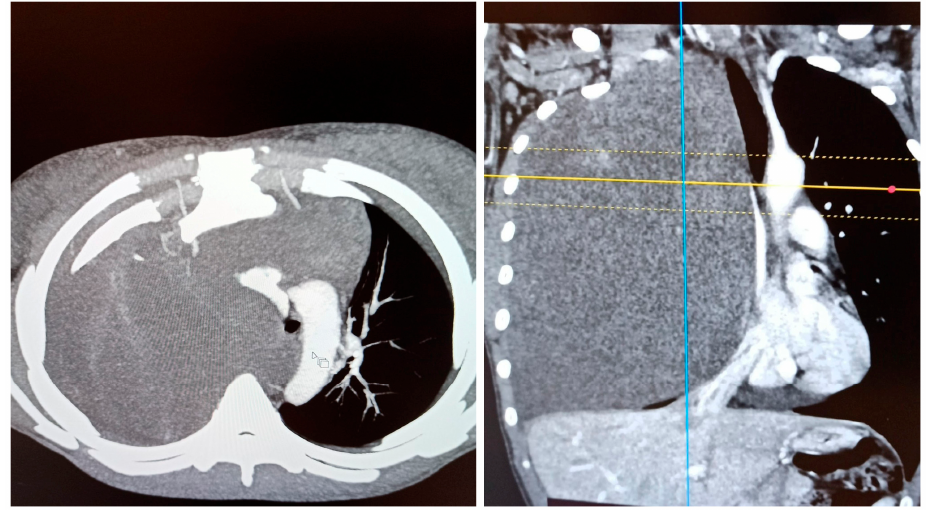
Figure 1. Preoperative CT-scan images of the tumor. Anesthetic management included basic (ECG, SpO2, EtCO2) as well as invasive blood pressure monitoring. Prior to induction of general anesthesia, a thoracic epidural catheter was placed at the T7-T8 interspace for optimal pain management. Induction to general anesthesia was achieved with intravenous midazolam 1 mg, fentanyl 100 mcg, and propofol 150 mg. Intubation was achieved with a 35 Fr left-side double-lumen tube and facilitated with rocuronium 40 mg. Correct placement of the tube was confirmed with flexible bronchoscopy. Maintenance of general anesthesia was achieved with a 1 MAC sevoflurane and bolus doses of ropivacaine 0.375% via the epidural catheter. The patient was ventilated with a tidal volume (Vt) of 5 mL/kg throughout surgery, given the col- lapsed right lung.